Question: Give a one-sentence summary of this figure.
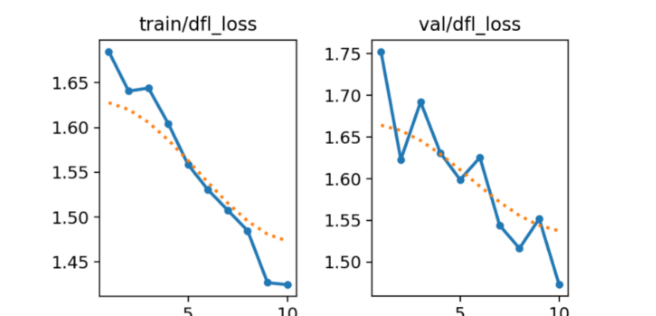
Answer: Distributional focal loss in YOLOv8